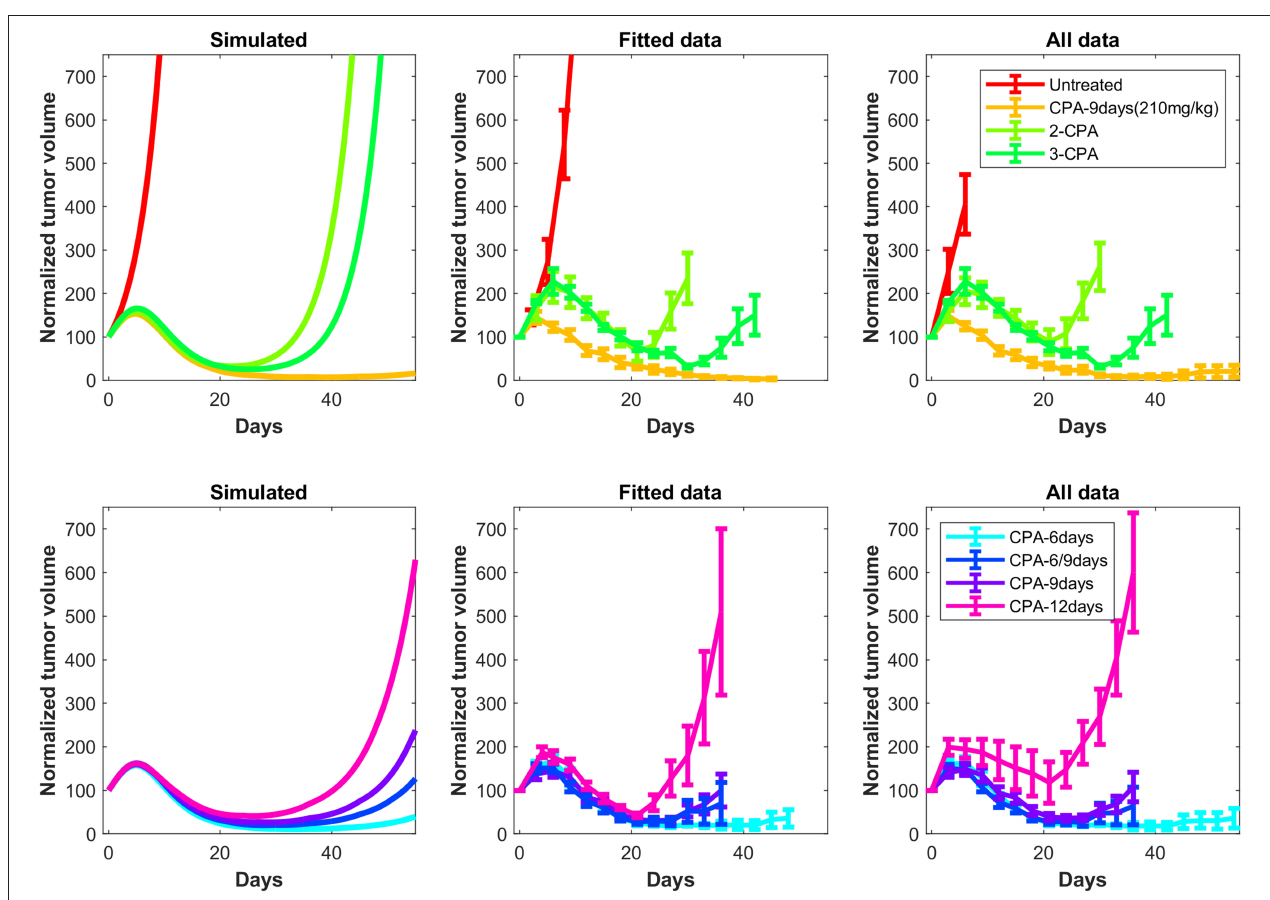
FIGURE 5 | Simulated tumor growth curves of all the considered treatments scenarios were normalized such that the first time point of each curve has an initial value of 100. The mean of the normalized curves for each treatment condition was then calculated and plotted on the left panels. The right panels are the original experimental data from Wu and Waxman ( 12). These data also show the difference between the normalized average fits of the fitted data without outliers (middle panels) and the experimental data including outliers (right panels). The outliers are highlighted in Supplementary Note 3